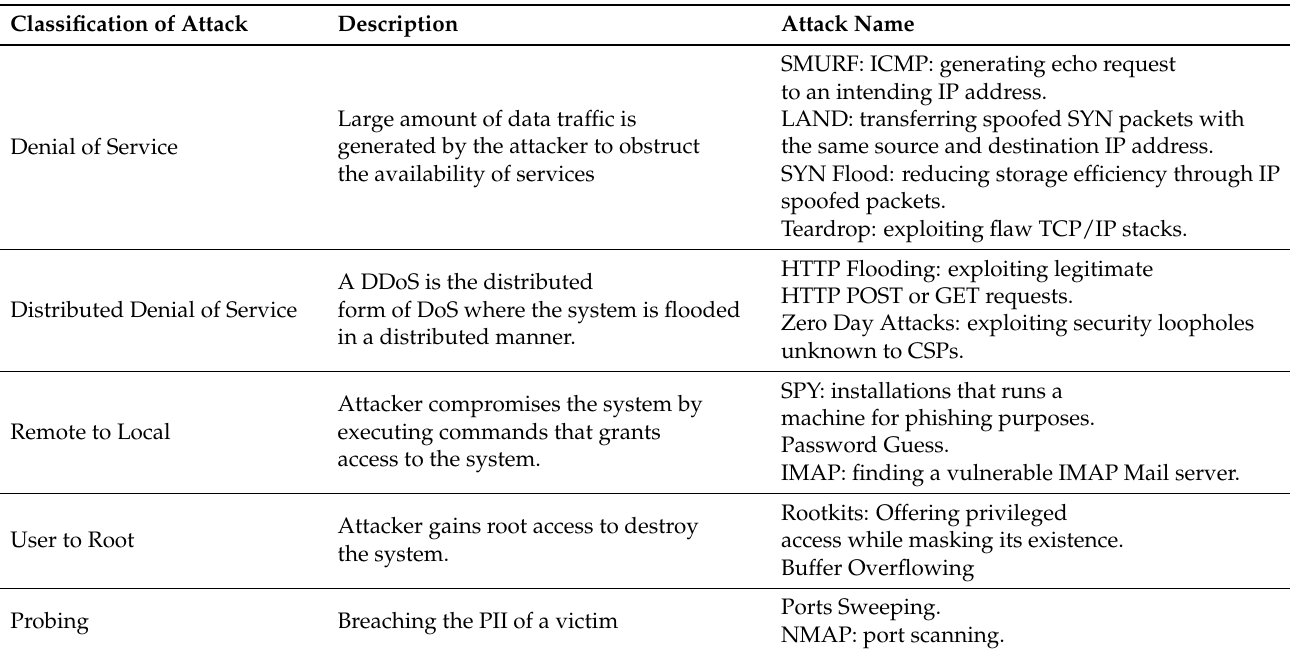
Table 8. Common security attacks.